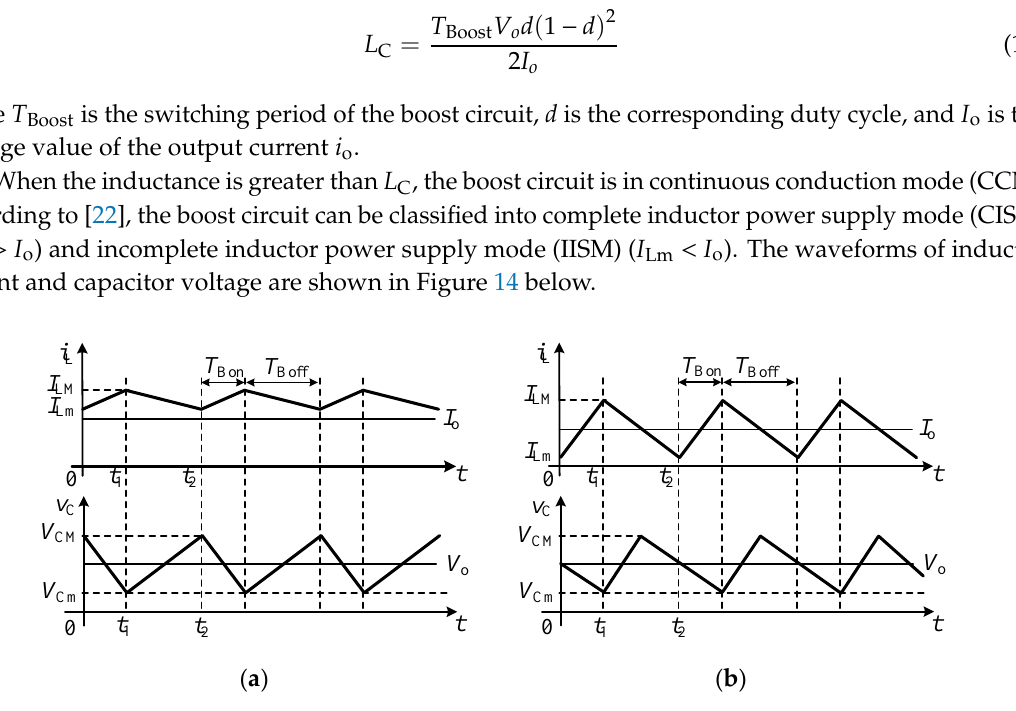
Figure 13. Current waveform of the boost circuit under critical state.